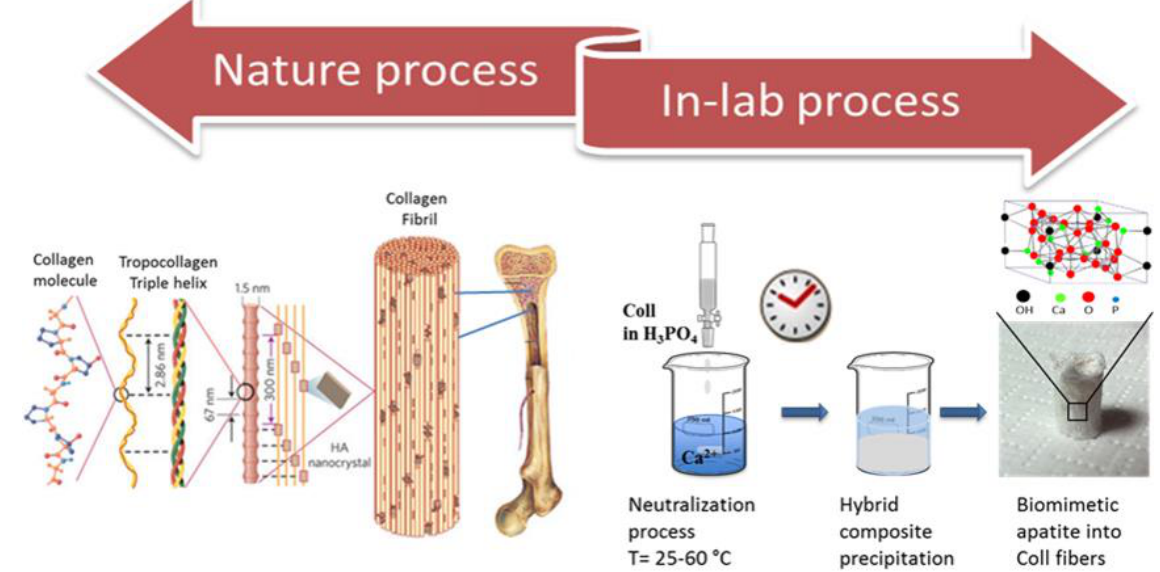
Figure 1. Schematic illustration of the naturally occurring structure of bone microstructure and the synthetic approach used to reproduce it. More in detail, in the natural occurring structure of bone, collagen fibers are organized in a triple helix, forming tropocollagen fibrils; these fibrils are tightly tied and reinforced by hydroxyapatite crystals; the organization and association of these fibrils confers peculiar structural and mechanical properties to the bone. Within the lab process, a collagen acidic solution containing phosphate ions (e.g., phosphoric acid) is dropwise added and mixed to a basic solution containing calcium ions (e.g., calcium hydroxide), promoting the formation of nano-hydroxyapatite crystals within the collagen fibers. Reproduced from “Biomineralization process generating hybrid nano-and micro-carriers” by E. Campodoni et al., 2018, Core-Shell Nanostructures for Drug Delivery and Theranostics: Challenges, Strategies, and Prospects for Novel Carrier Systems, 19–24, (doi:10.1016/C2016-0-03458-7) (Under a Creative Commons Attribution 4.0 International License).